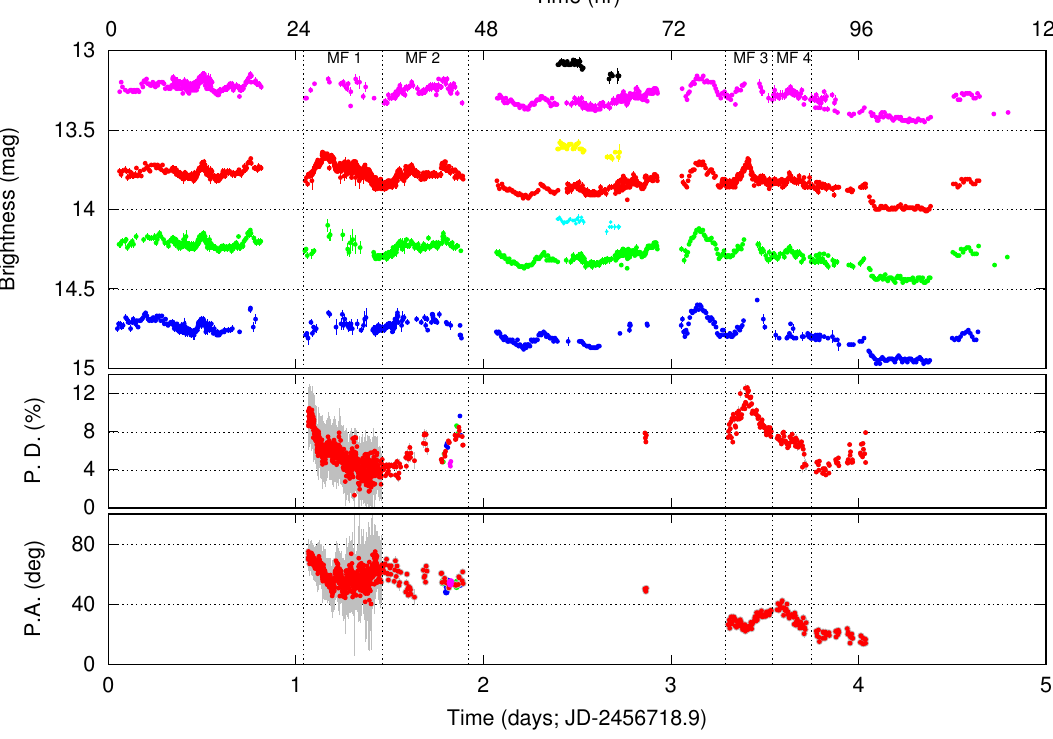
Figure 2. ( Top ): WEBT light curves in optical bands B (blue), V (green), R (red), I (magenta), J (black), H (yellow), and K (cyan); ( Middle ): Polarization degree (P.D.) in bands R (red) and B (blue); ( Bottom ): Polarization angle (P.A.) in bands R (red) and B (blue)